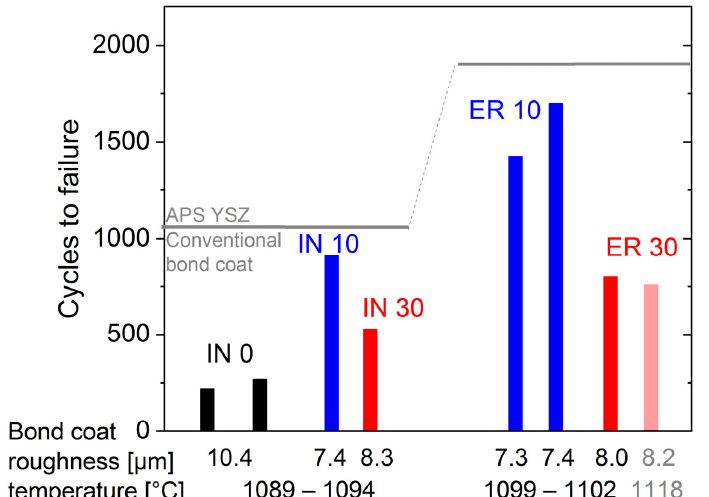
Figure 3. SEM cross section of thermally cycled TBCs using columnar yttria-stabilized zirconia SPS top coat, Co-based alumina oxide-dispersion-strengthened bond coats (10% and 30% alumina) and conventional Co-based bond coat underneath (on ERBO 1 substrate—not visible).